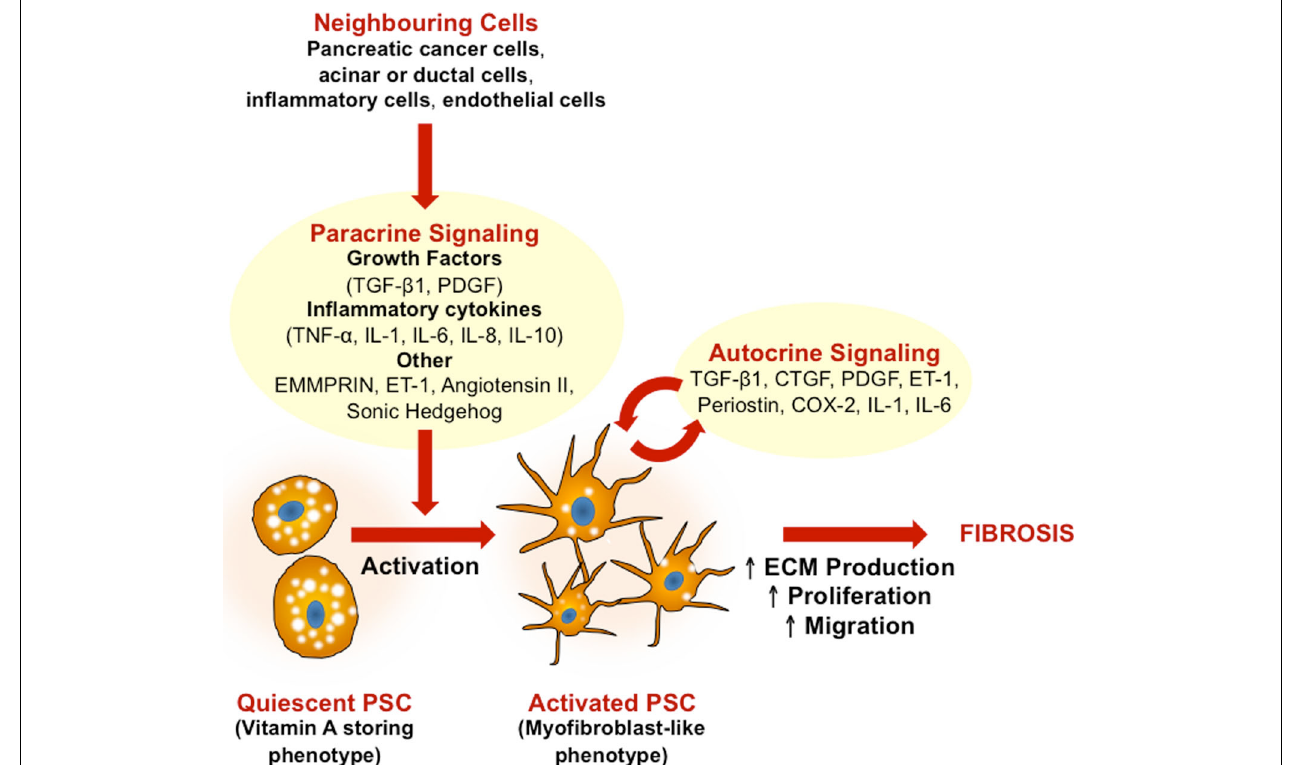
FIGURE 1 | Mechanisms of pancreatic stellate cell (PSC) activation. A central feature of PSCs is the transformation from a quiescent (fat storing phenotype) to an activated (myofibroblast-like phenotype) state. Growth factors and pro-inflammatory cytokines released by neighboring cells (pancreatic cancer cells, injured acinar or ductal cells, inflammatory cells, and endothelial cells) all induce PSC activation. Activated